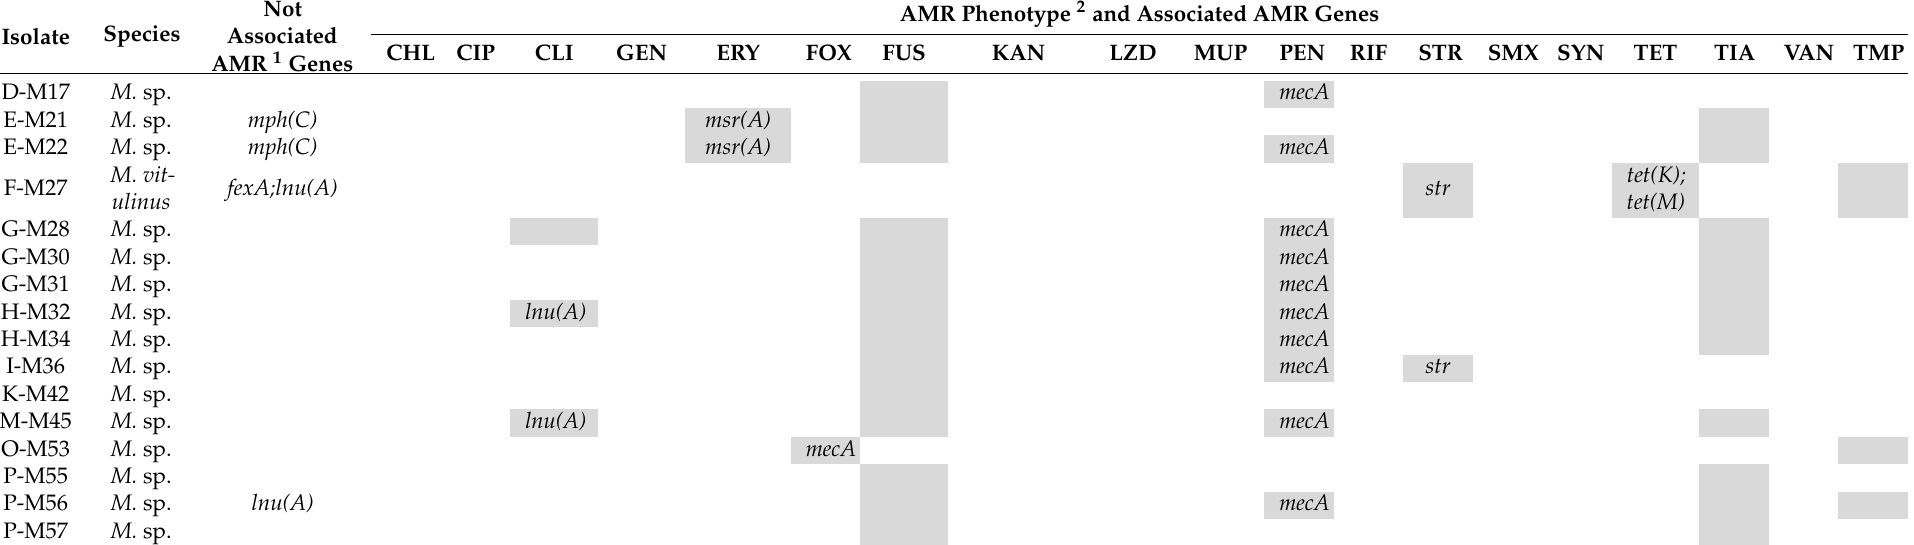
Table 3. Predicted antimicrobial resistance genes compared to phenotype according to minimum inhibitory concentrations of various antimicrobial substances for M. sp. and M. vitulinus isolates. Non-wildtype phenotypes were evaluated according to EUCAST ECOFFs. Grey background represents resistance to respective antimicrobial